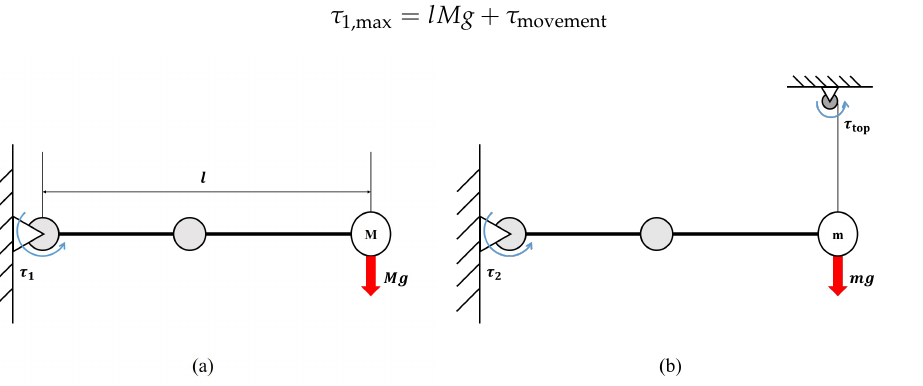
Figure 3. Comparison of the maximum gravity compensation torque at and ( a ) 2 DoF planar manipu- lator and ( b ) 2 DoF planar manipulator with a wire-driven direct-gravity compensation system. The link’s weight and the actuator were ignored. Conversely, if the wire is directly connected to the end where the load is concentrated to compensate for gravitational force, the maximum torque is rMg , where r is the radius of the